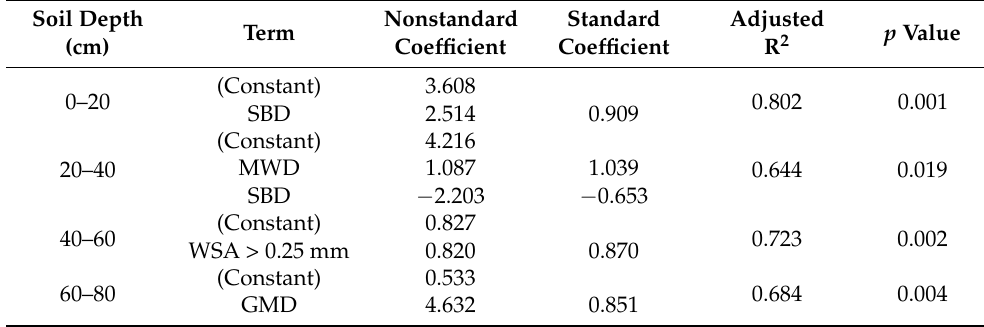
Table 2. Stepwise multivariate regression analysis of the SOC stocks at different depths.